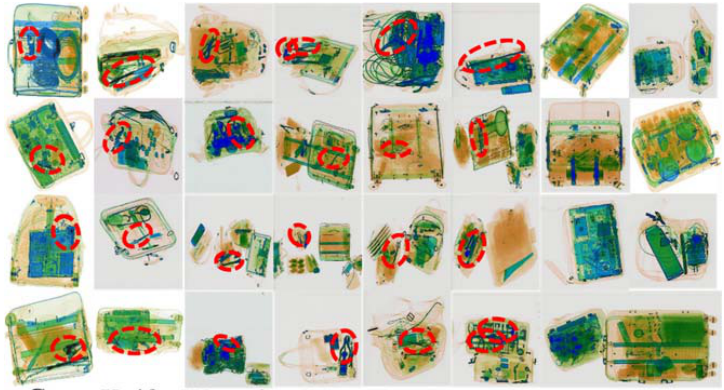
Figure 3. Sample images in SIXray dataset.